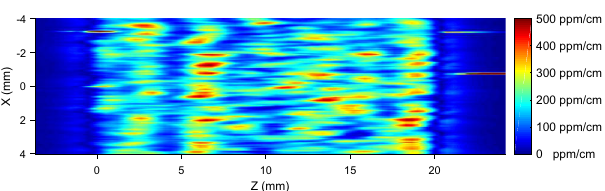
Figure 4. Rectangular map showing the XZ section of Sample